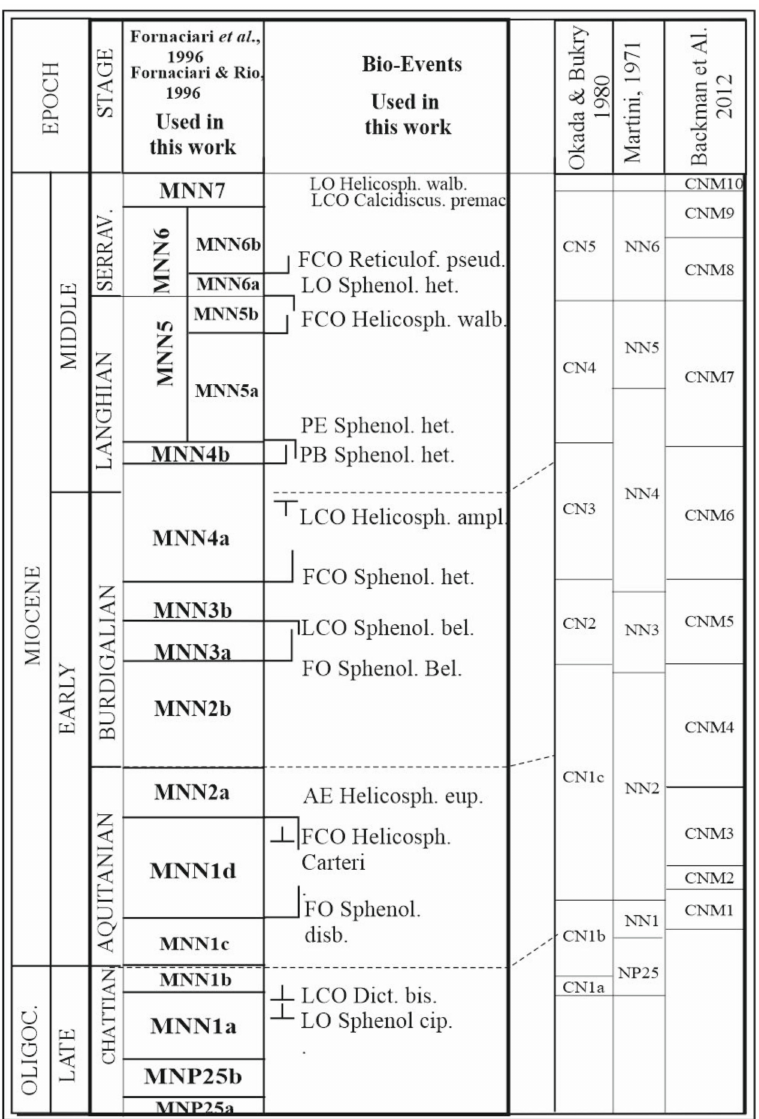
Figure 2. Biostratigraphic scheme for the Upper Oligocene-Middle Miocene interval. The scheme correlates the nannofossils biozonations proposed by [35,37], used in this work, with the Standard ones by [38,39], recently updated by [41]. The scheme is also integrated (bold rectangle) with the main bio-event characterizing the Mediterranean